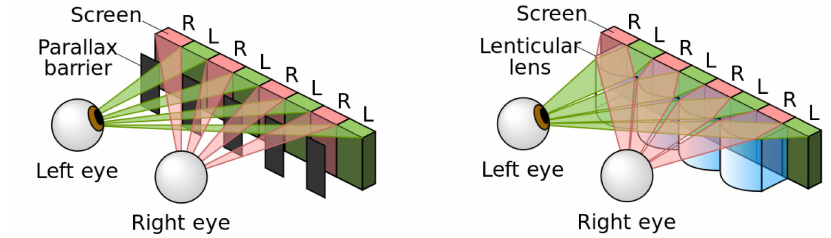
Figure 4. “Parallax barrier vs. lenticular screen” by Cmg Lee. Licensed under CC BY-SA 3.0 via